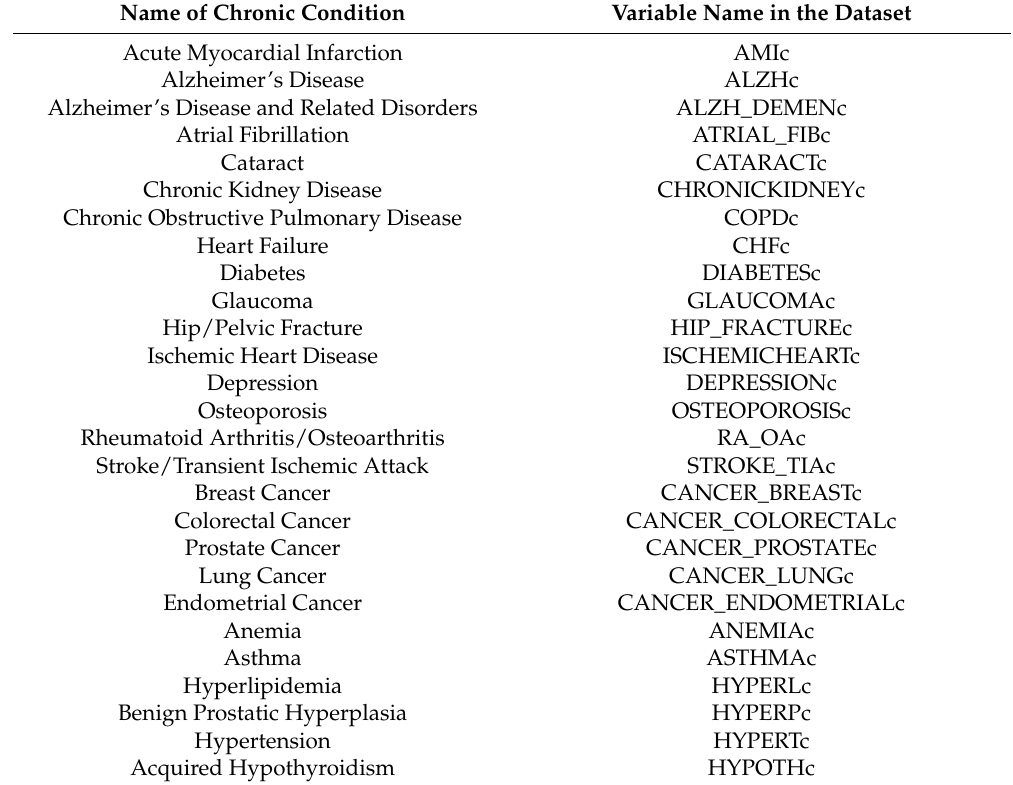
Table A1. CMS chronic Conditions.